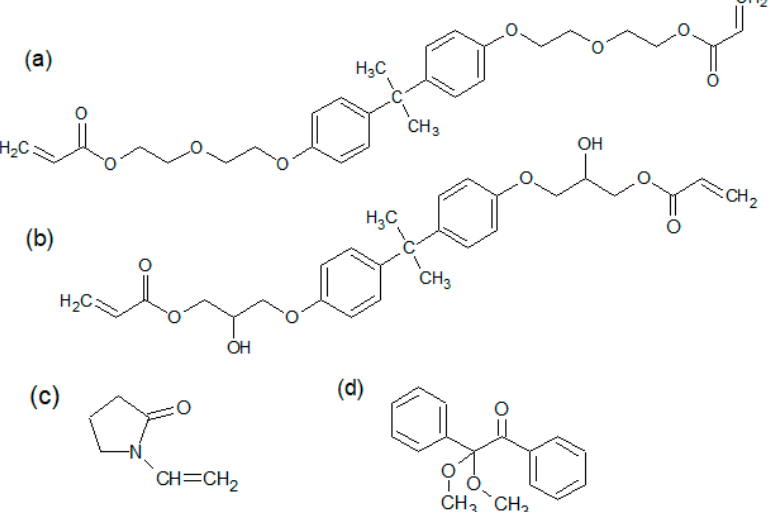
Figure 4. Chemical structures of the reactants used for preparation of copolymers and polymeric blends: ( a ) Ebecryl ® 150 (EB-150); ( b ) Ebecryl ® 600 (EB-600); ( c ) N-vinyl-2-pyrrolidone; ( d ) 2,2-dime- thoxy-2-phenyloacetophenone (Irgacure ® 651). Table 3. Amounts of chemical compounds used for polymerization of bisphenol Z polysulfone. EB-150 or EB-600 (wt.%) NVP (wt.%) PSU-BPZ (wt.%) Irgacure ® 651 (wt.%)